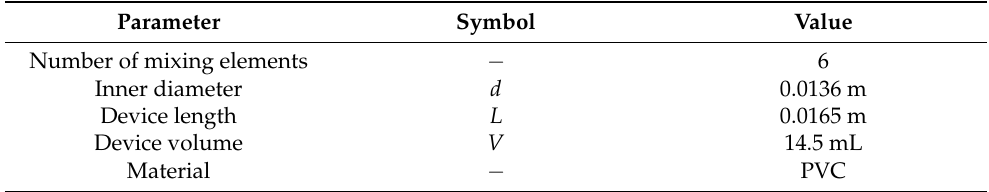
Table 1. Parameters of multifunctional reactor—static mixer